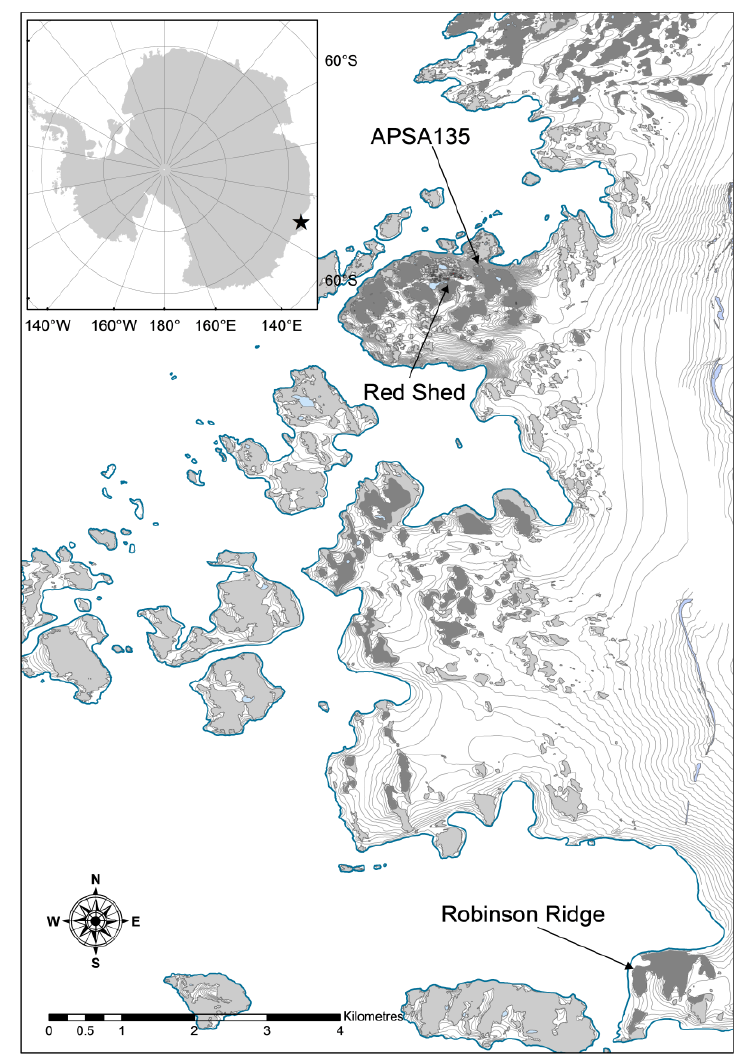
Figure 1. Site location map for the three Antarctic test